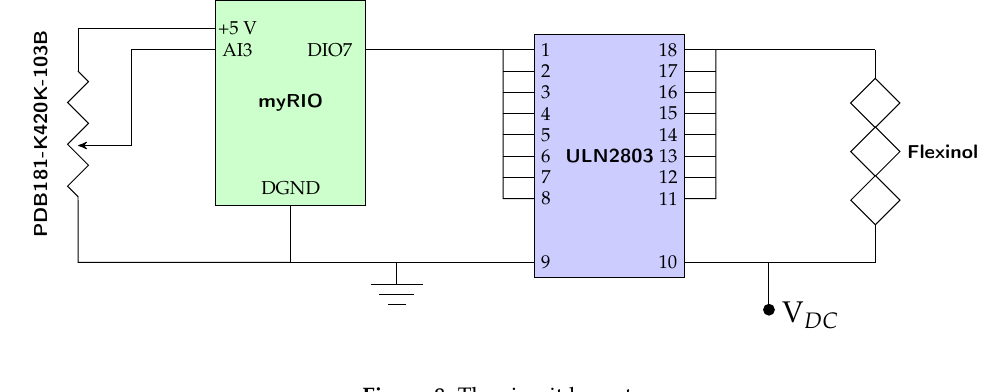
Figure 8. The circuit layout.